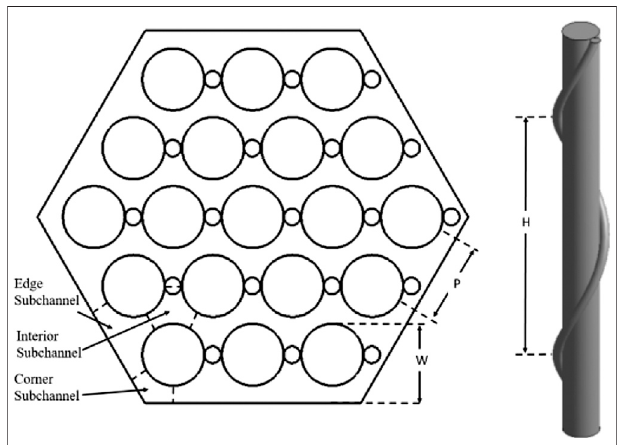
FIGURE 1 | A typical wire-wrapped fuel assembly con fi